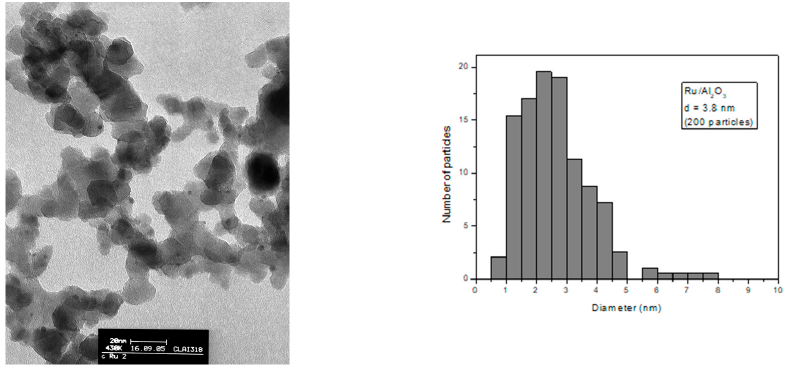
Figure 2. Transmission electron microscope (TEM) pictures and size distribution of the Al 2 O 3 supported Pd, Pt, Rh and Ru catalysts. Table 3. Properties of catalysts: particles size and metallic accessibility.